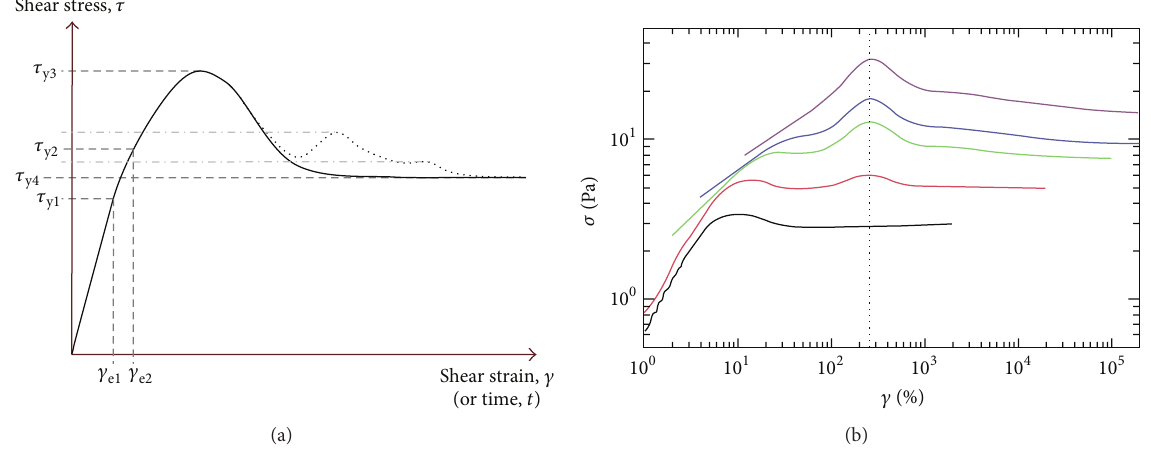
Figure 3: (a) Typical response of shear stress over time for a hypothetical material exhibiting a shear yield stress, at a small, constant shear strain rate. Four different “yield” points are indicated (cf. [54, 73, 95]). The relative magnitudes of the identified stresses, 𝜏 y 𝑖 , may vary. In the dotted profile, two additional yielding events are depicted at much larger values of shear strain. (b) Responses in step rate tests of a depletion flocculated particulate gel (or glass) at 𝜑 = 0.44 and ̇𝛾 = 0.1 , 1, 5, 10, and 30 s −1 (increasing from bottom to top). (Reproduced from Koumakis and Petekidis [60] with permission of The Royal Society of